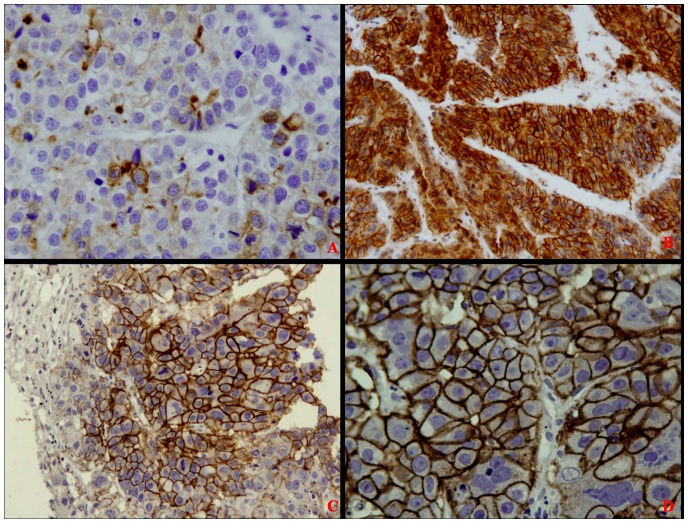
GPC3 immunohistochemical staining in HCC.(Figure A ×200, B ×200, Figure C ×200, D ×400). A) weakly positive; B, C, and D) strongly positive.